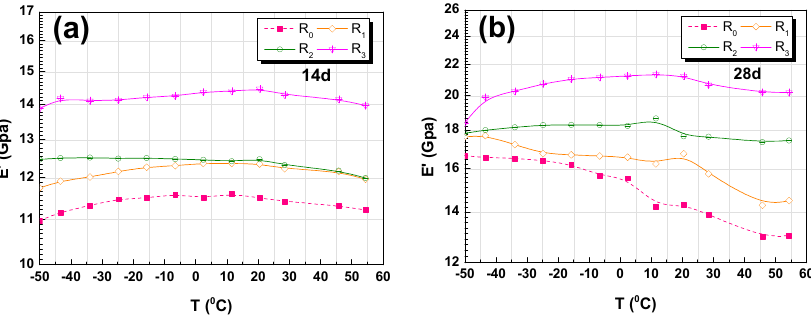
Figure 9. DMA analysis results of E’ versus temperature: ( a ) 14-day; and, ( b ) 28-day.